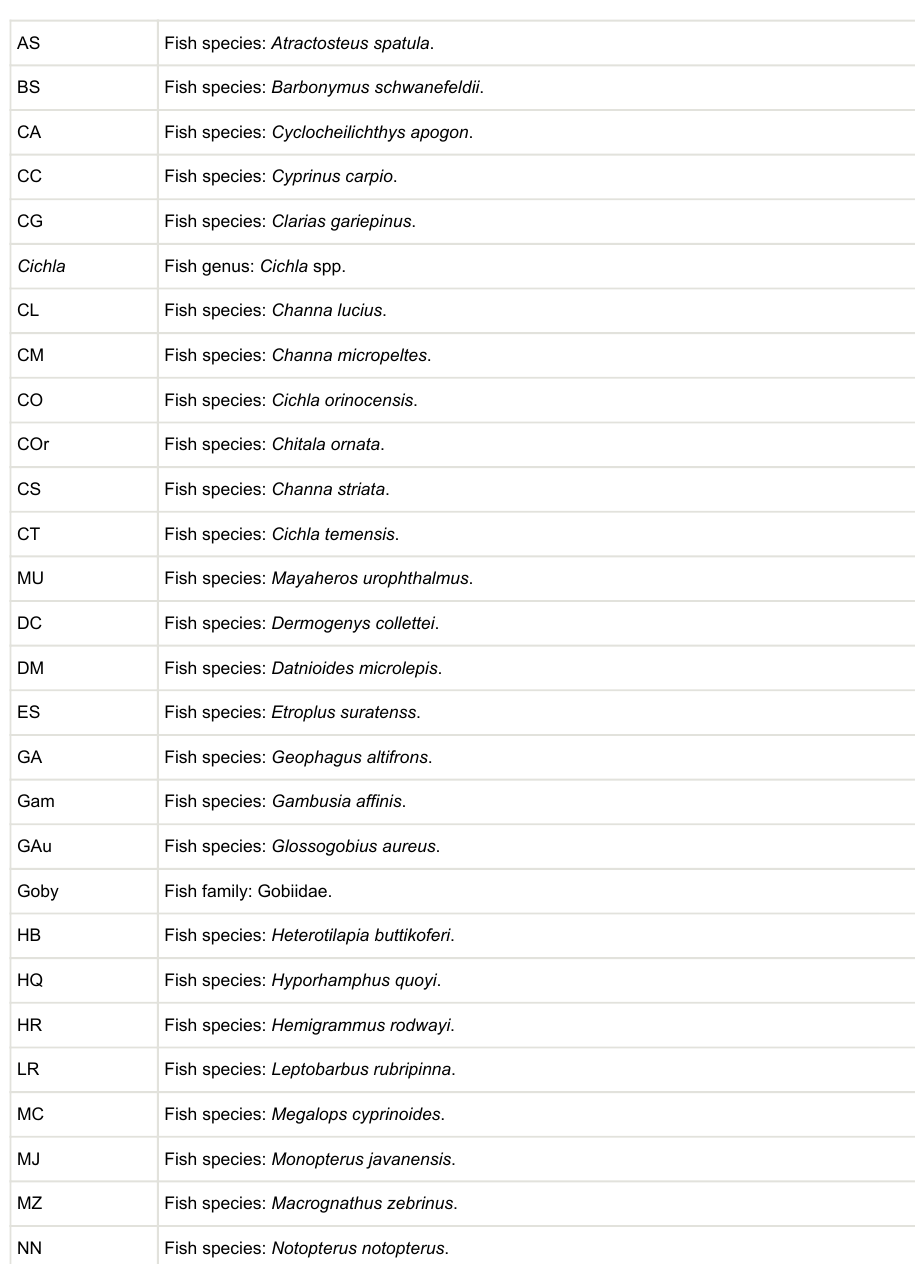
AS Fish species: Atractosteus spatula . BS Fish species: Barbonymus schwanefeldii . CA Fish species: Cyclocheilichthys apogon . CC Fish species: Cyprinus carpio . CG Fish species: Clarias gariepinus . Cichla Fish genus: Cichla spp. CL Fish species: Channa lucius . CM Fish species: Channa micropeltes . CO Fish species: Cichla orinocensis . COr Fish species: Chitala ornata . CS Fish species: Channa striata . CT Fish species: Cichla temensis . MU Fish species: Mayaheros urophthalmus . DC Fish species: Dermogenys collettei . DM Fish species: Datnioides microlepis . ES Fish species: Etroplus suratenss . GA Fish species: Geophagus altifrons . Gam Fish species: Gambusia affinis . GAu Fish species: Glossogobius aureus . Goby Fish family: Gobiidae. HB Fish species: Heterotilapia buttikoferi . HQ Fish species: Hyporhamphus quoyi . HR Fish species: Hemigrammus rodwayi . LR Fish species: Leptobarbus rubripinna . MC Fish species: Megalops cyprinoides . MJ Fish species: Monopterus javanensis . MZ Fish species: Macrognathus zebrinus . NN Fish species: Notopterus notopterus . OG Fish species: Osphronemus goramy . OH Fish hybrid genus: Oreochromis spp. (hybrid). OJ Fish species: Oryzias javanicus